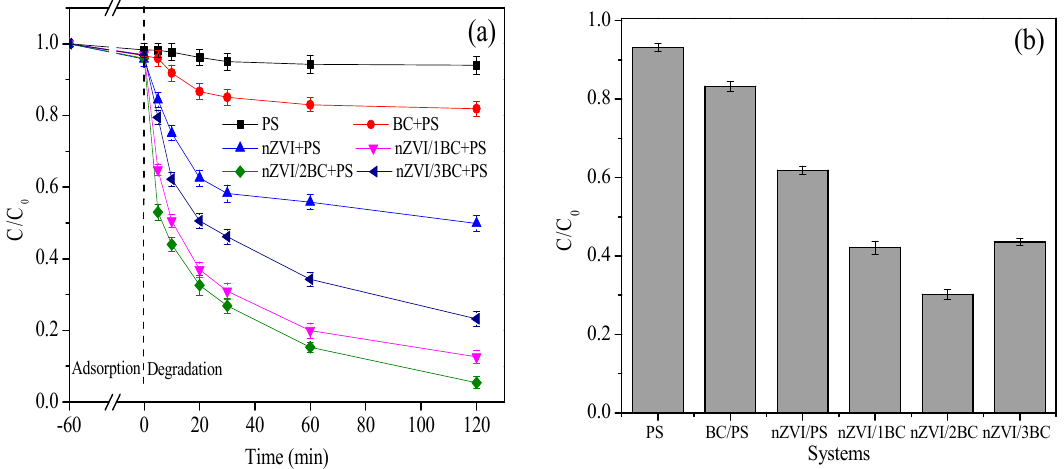
Figure 6. ( a ) The degradation of DTZ in different systems. ( b ) The residual of persulfate (PS) in different systems. [DTZ] = 20 mg L − 1 ; [PS] = 25.0 mM; [BC] = 0.30 g L − 1 ; [nZVI] = 0.15 g L − 1 ; Temp = 25 °C; pH = 7.0.